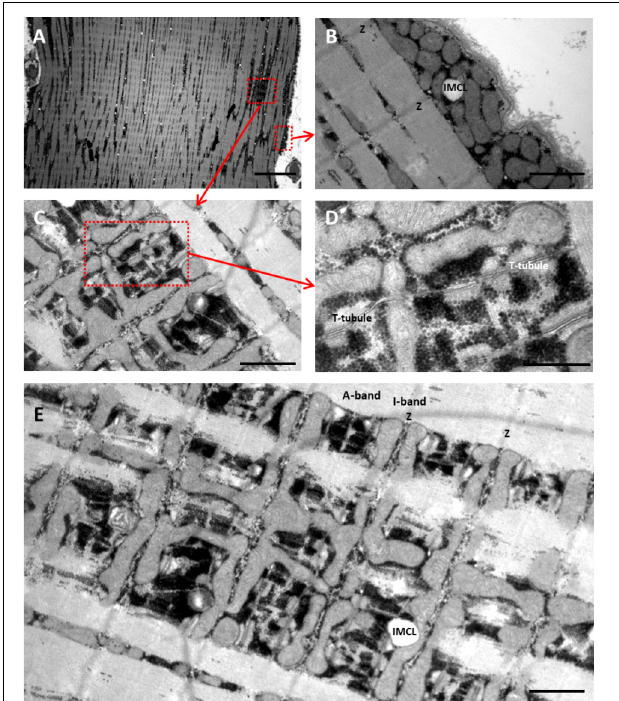
FIGURE 1 | TEM images showing the subcellular localization of skeletal muscle mitochondria. All images are from leg muscle ( vastus lateralis ). (A) Overview of a part of fiber showing the myofibrillar (Myo) space and subsarcolemmal (SS) space. (B) The typical localization of SS mitochondria (mit) in skeletal muscle, also showing a intramyocellular lipid (IMCL). (C) In the Myo space, intermyofibrillar mitochondria are wrapped around the myofibrils, mainly in the I-band and often connected to an adjacent mitochondrion through the A-band. There is less marked connection between neighboring mitochondria in the I-band. (D) Intermyofibrillar mitochondria in the I-band on each side of the Z-line, with the t-tubular system (t-system) and mitochondria intertwined. (E) Overview demonstrating the IMF mitochondria are mainly located in the I-band on each side of the z-line and often connected to an adjacent mitochondrion in the same sarcomere through the A-band. All the gray structures in the fiber are mitochondria with slightly visible inner cristae. Glycogen granules can be seen as black dots. Z, Z-line; A, A-band; IMCL, intramyocellular lipid; T-tubule, transverse tubular system. Scale bar: A , 10 µ m; B , C , 1 µ m; D , 0.5 µ m; E , 1 µ m. Original magnification: A , x1,600; B,C , x20,000; D , x50,000; E ,